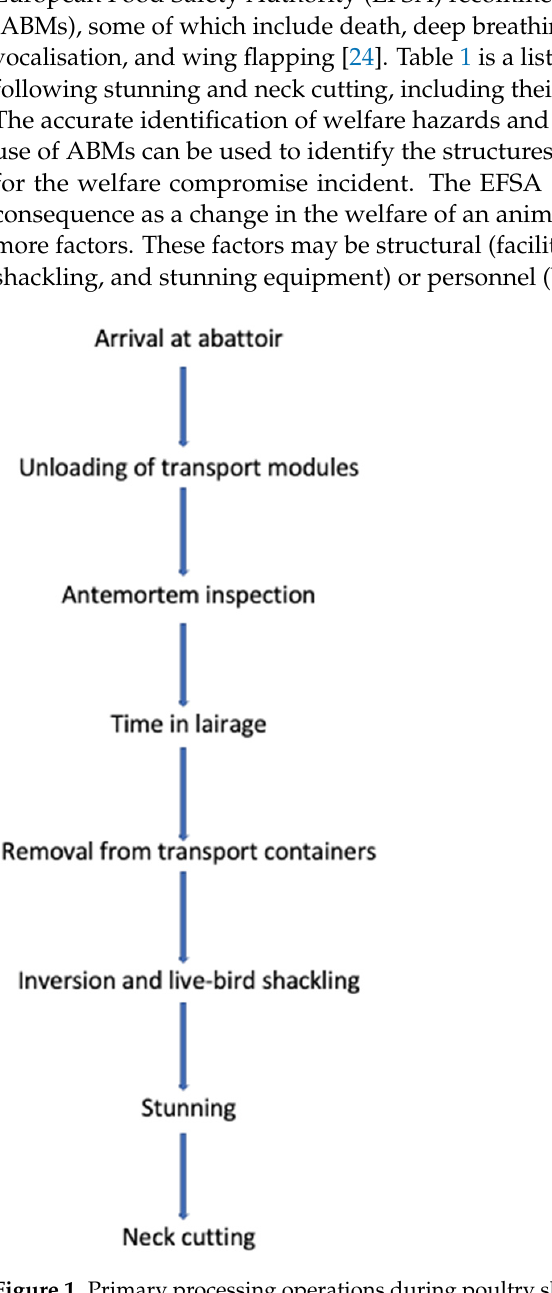
Figure 1. Primary processing operations during poultry slaughter with water bath stunning (adapted from Fuseini et al. [26], permission